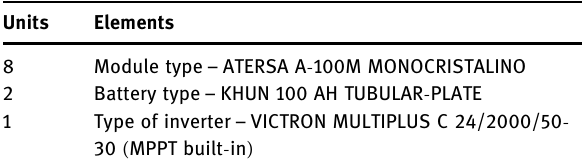
Table 11: Stand - alone PV components ( mathematical calculations )